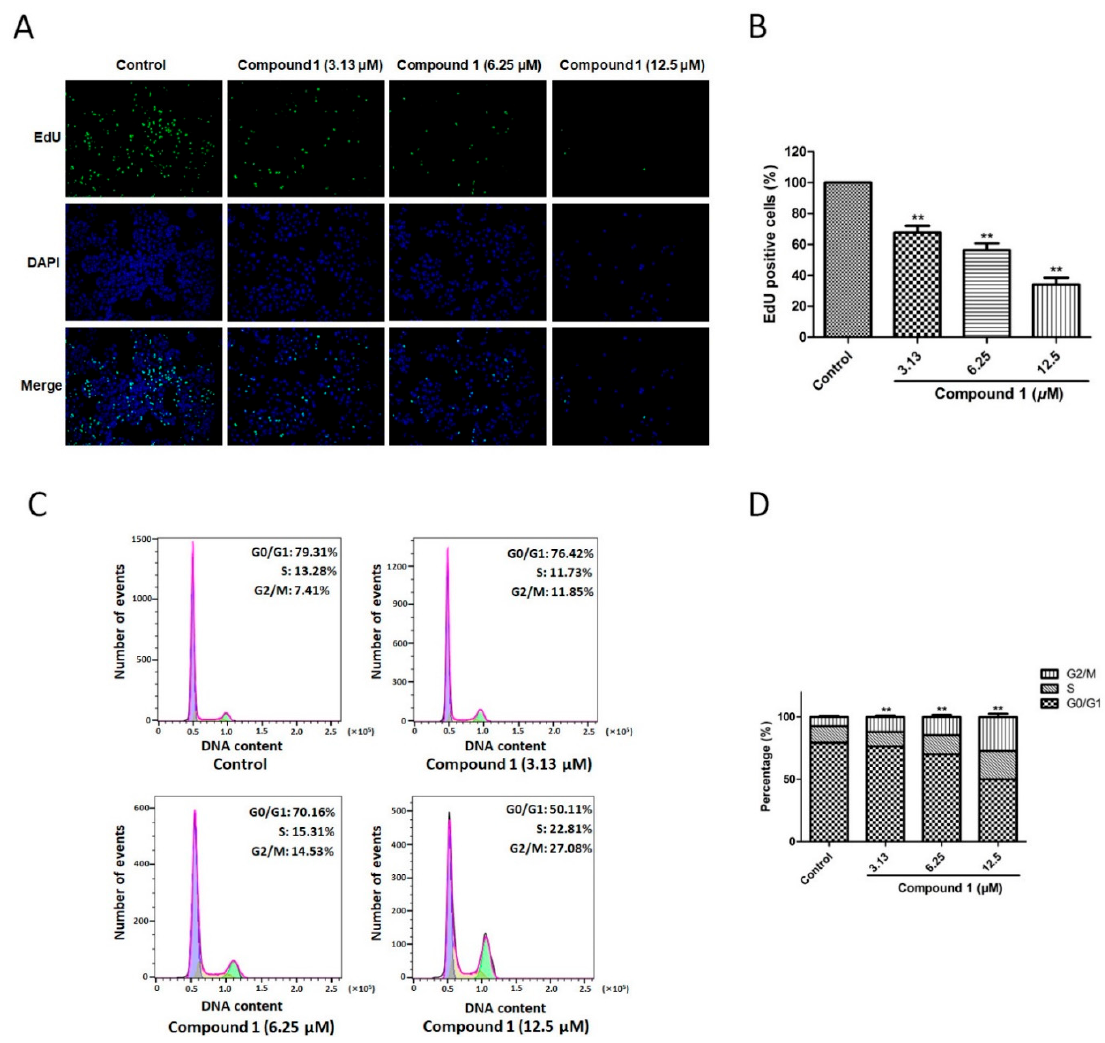
Figure 3. Effect of compound 1 on proliferation of A549 cells. ( A ) Images of control, compound 1 (3.13 μ M), compound 1 (6.25 μ M), and compound 1 (12.5 μ M) groups were captured by a microscope in an EdU staining assay. ( B ) Treatment with 3.13, 6.25, and 12.5 μ M of compound 1 notably reduced EdU-positive cells. ( C ) Cell cycle analysis of control, compound 1 (3.13 μ M), compound 1 (6.25 μ M), and compound 1 (12.5 μ M) groups were performed by flow cytometry. ( D ) Treatment with 3.13, 6.25, and 12.5 μ M of compound 1 dramatically increased the percentage of cells in the G2/M phase. Data are shown as the mean ± SD ( n = 3). ** p < 0.01 in comparison with the control group.